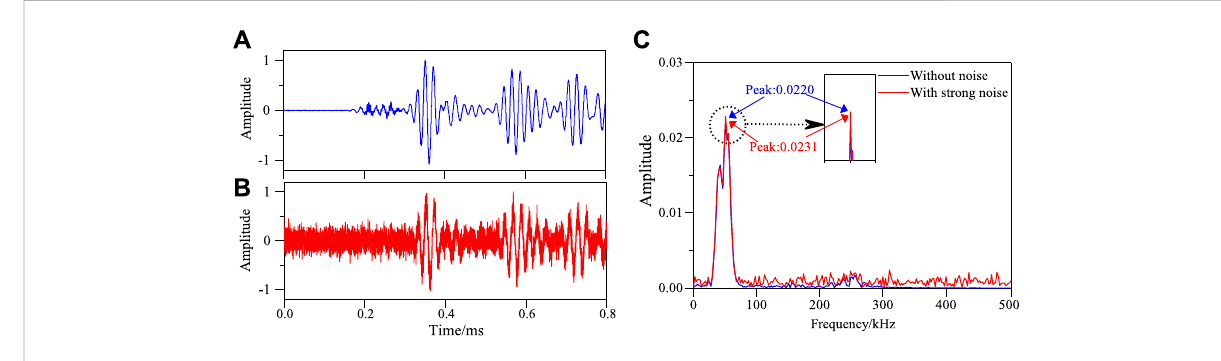
FIGURE 18 Frequency spectrum of S1 – S7 sensing channel without damage in structure under strong noise environment. (A) Effective signal- undamaged. (B) After adding 3 dB with noise. (C) Frequency spectrum of S1 – S7 signal sensing channel.